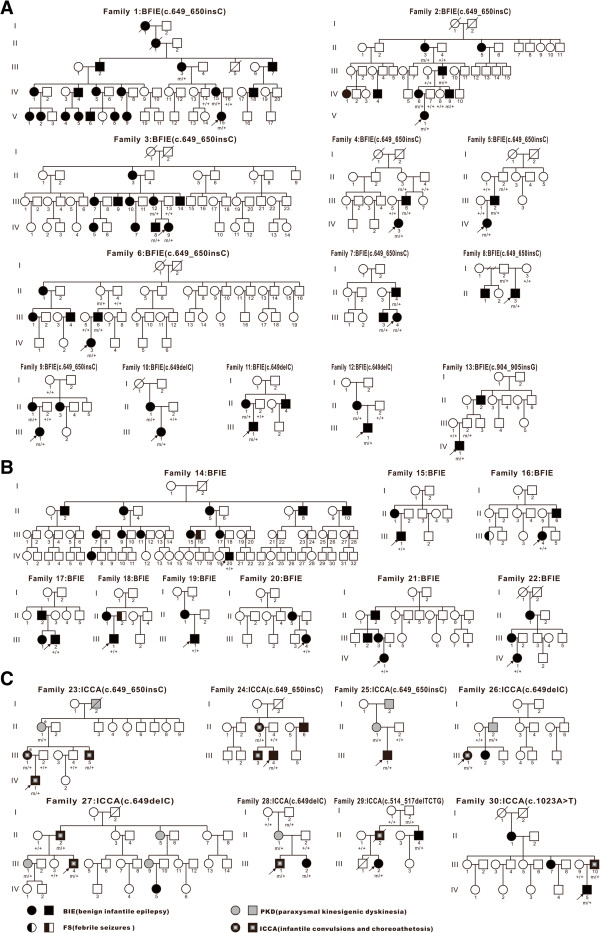
Pedigrees of the 22 BFIE families and 8 ICCA families. The arrow indicates the proband. An individual with a heterozygous PRRT2 mutation is indicated by m/+, and an individual without a PRRT2 mutation is indicated by +/+. An individual with an asterisk is a patient with migraine. (A) Pedigrees of families 1-13: thirteen BFIE families with a PRRT2 mutation, (B) Pedigrees of families 14-22: nine BFIE families without a PRRT2 mutation, (C) Pedigrees of families 23-30: eight ICCA families with a PRRT2 mutation.